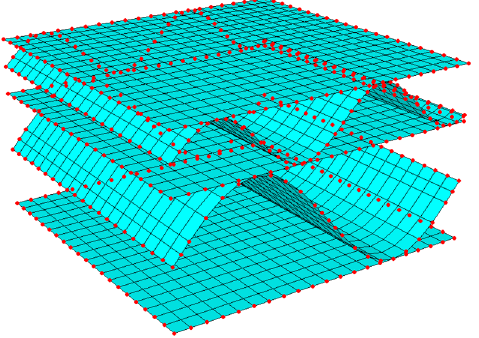
Figure 2. Finite elements and nodes (external, in red color) of the RVE of a double-walled corrugated board.